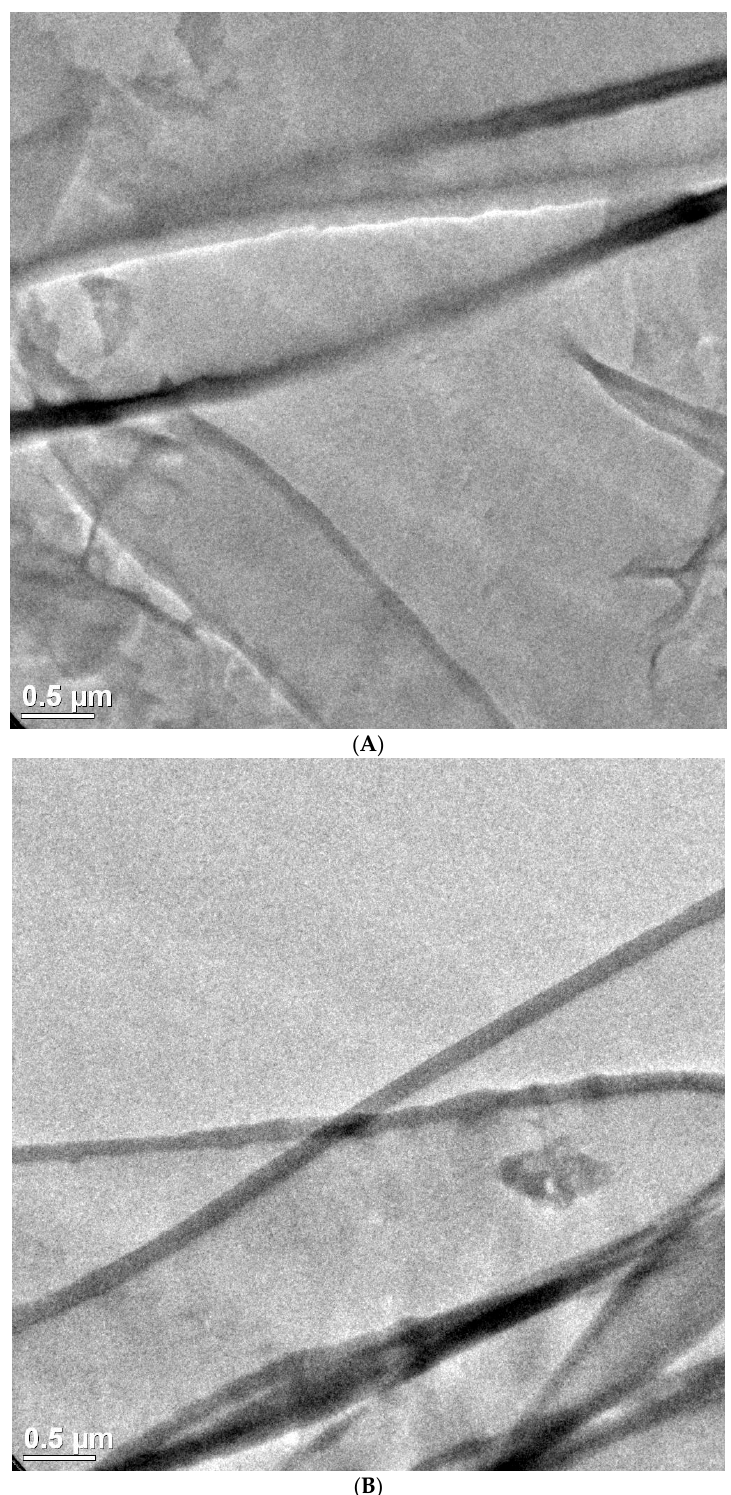
Figure 2. TEM micrographs for ABA film containing 1.0 wt % MWCNT in the A-layers fabricated using masterbatch with MFI = 34 g/10 min with ultrasound-assist method V-U. ( A ) MWCNTs near to each other, and ( B ) MWCNTs touching to each other.